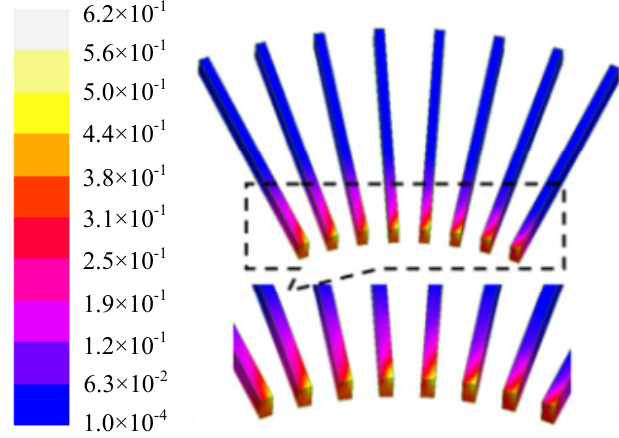
Figure 6. Flux density of the finger plate